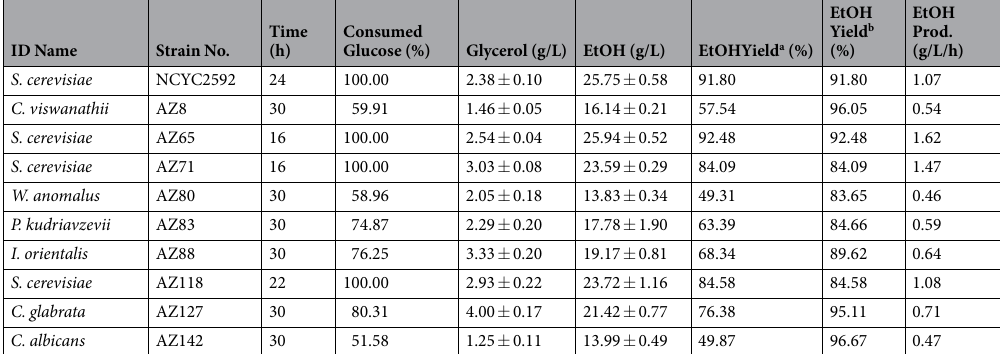
Table 2. HPLC analysis of fermentation samples of marine yeasts under screening for ethanol producing yeast using SW-YPD medium. a Calculated as a percentage of the theoretical yield (0.51) based on the total